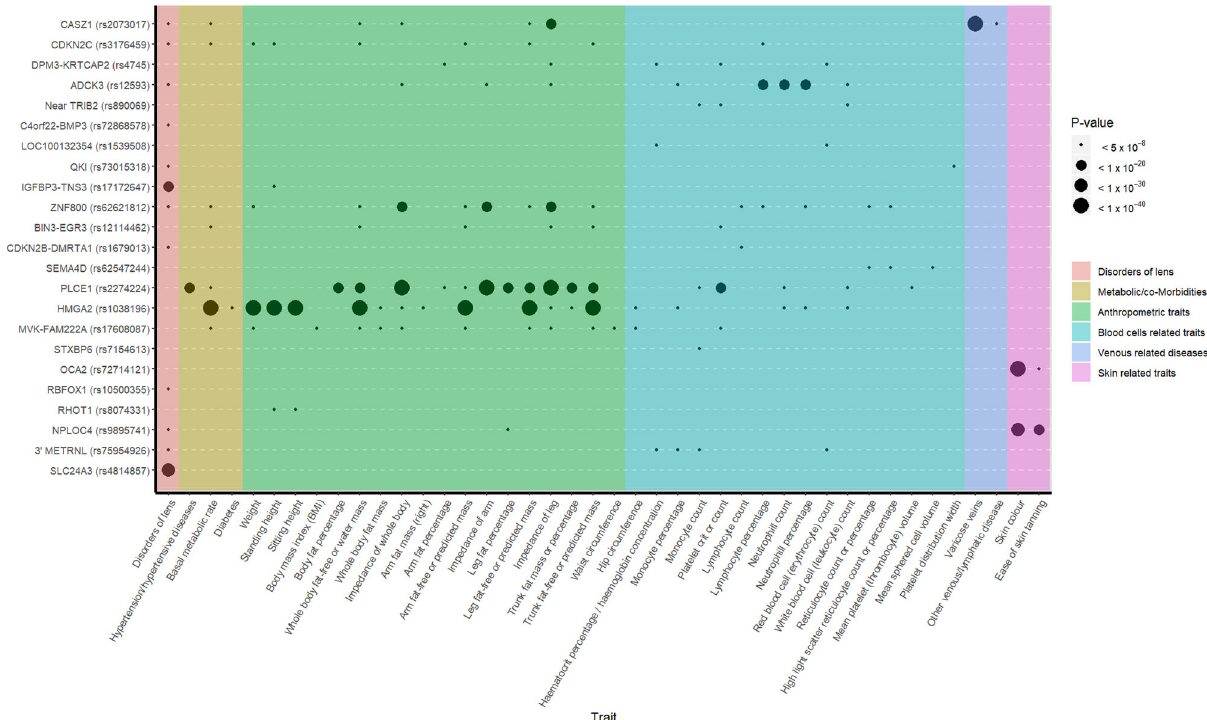
Fig. 4 Phenome-wide association matrix of cataract top variants. PheWAS was carried out for the 54 lead SNPs in our loci of interest identi fi ed in the combined (GERA + UKB) multiethnic analysis. SNPs were queried against 776 traits ascertained for UKB participants and reported in the Roslin Gene Atlas 60 , including disorders of the lens, anthropometric traits, hematologic laboratory values, ICD-10 clinical diagnoses and self-reported conditions. Among the 54 lead SNPs, 43 were available in Gene Atlas database. We reported SNPs showing genome-wide signi fi cant association with at least one trait (in addition to